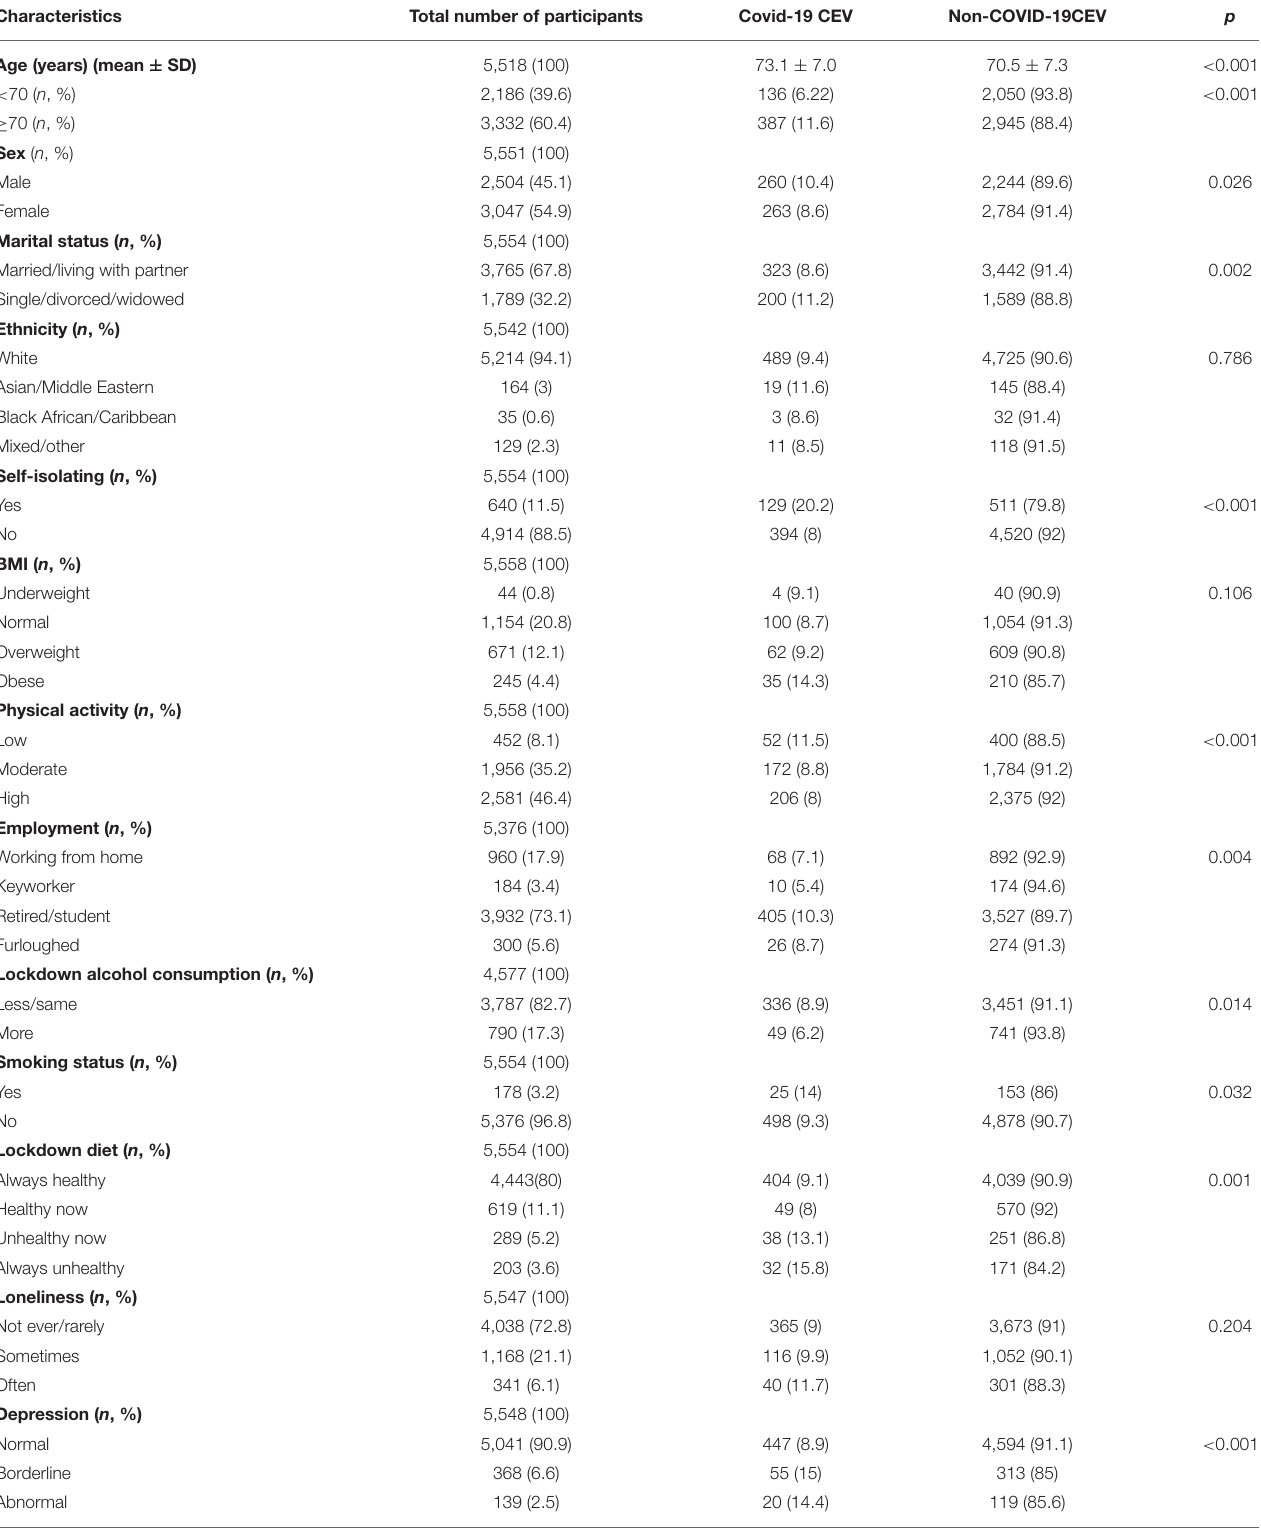
TABLE 1 | Population characteristics of study cohort ( n = 5,558) in relation to COVID-19CEV status.